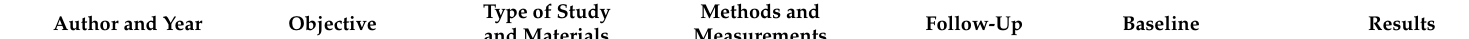
Table 1. Summary of studies examining bone structural and metabolic alterations in OA in the presence of